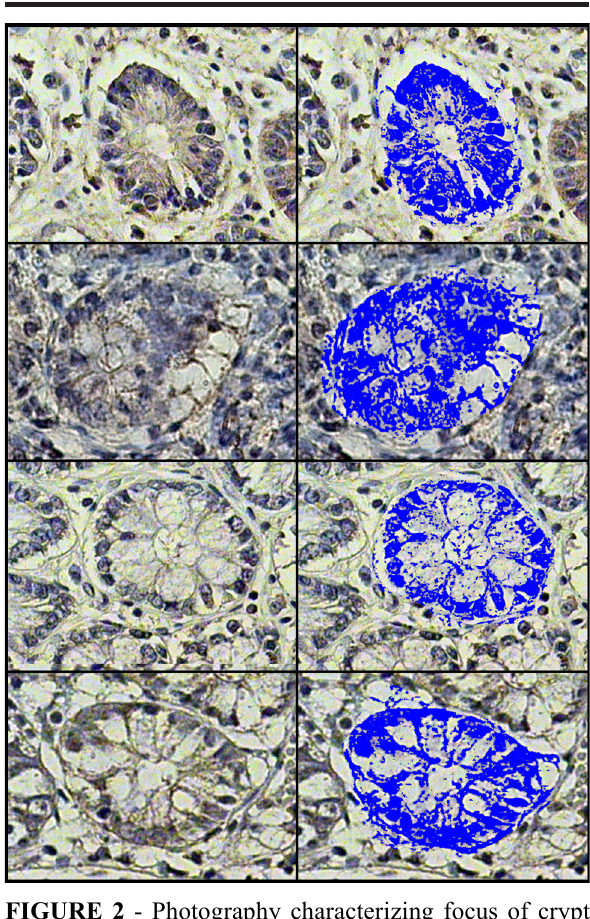
FIGURE 2 - Photography characterizing focus of crypt aberrant, in cut sagital, submitted a procedure imunohistochemistry with expression SOD1 brown color. Imageprocessing attended by computer and visualization of the expression SOD1 in the blue coloration. The image corresponds representative sample of the average in each group.